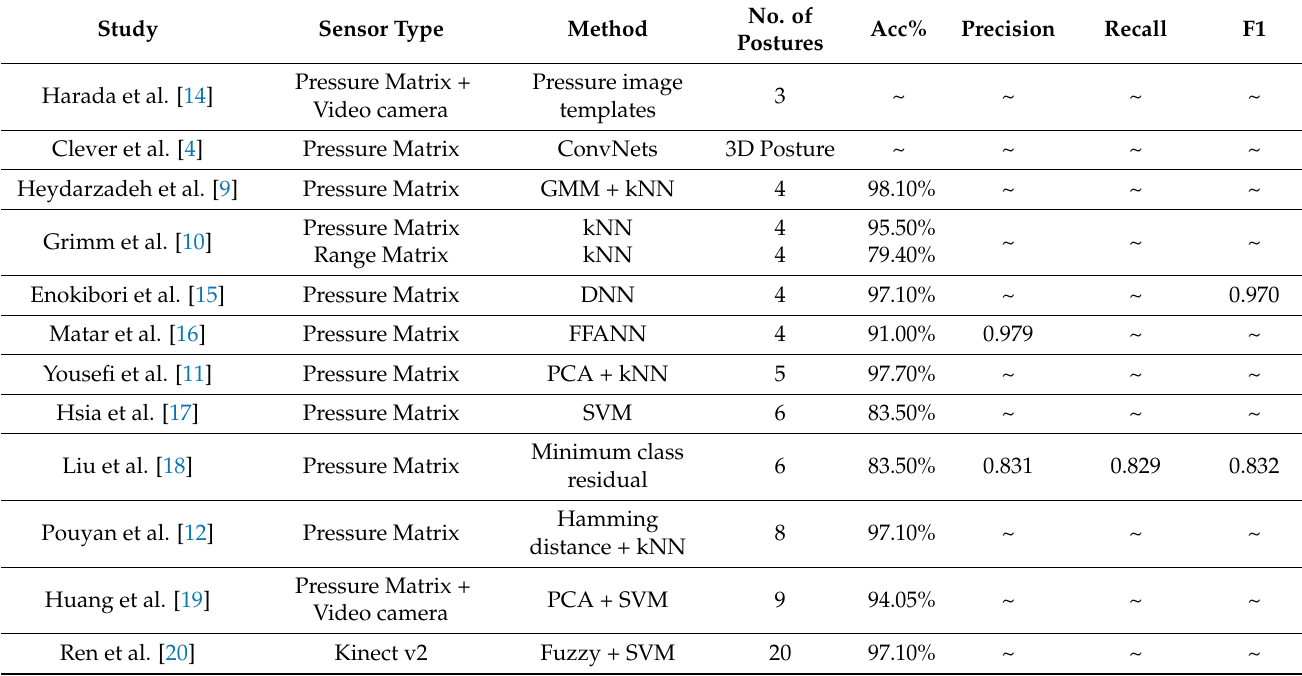
Table 1. Performance of fuzzy inferred convolutional neural network (CNN) with Long short-term memory model, ConvLSTM, compared to other